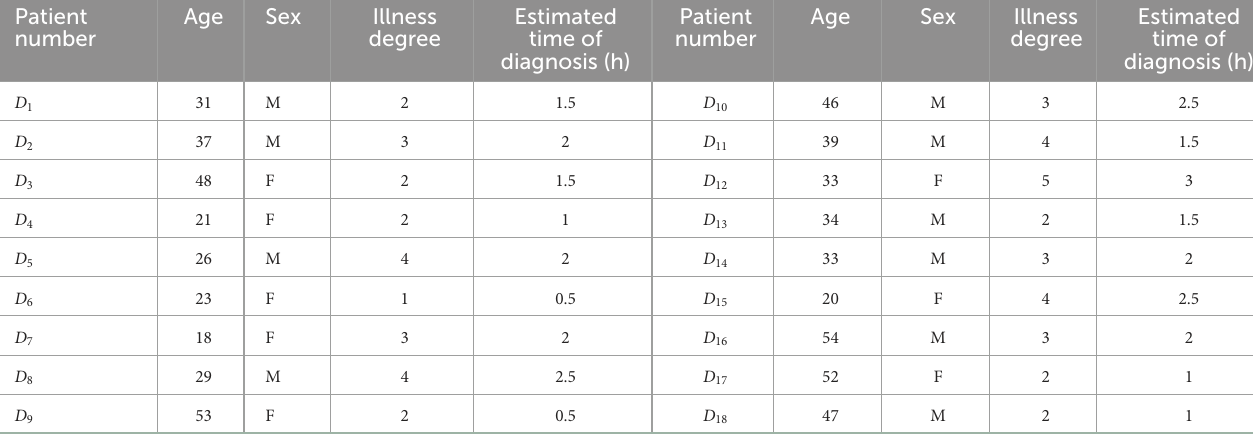
Age Sex Illness